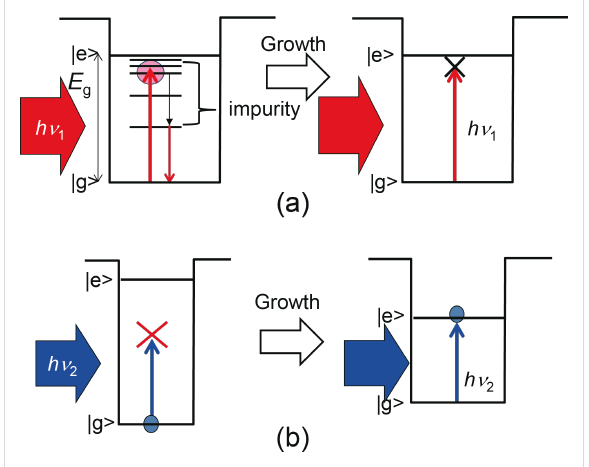
Figure 1: Schematic of the photo-induced synthesis. (a) Selective etching of defect levels. The relationship between the energy of an incident photon and the band structure of a ZAIS nanocrystal is shown in the left panel. As growth proceeds, the defect levels disappear, resulting in the high-quality nanocrystal at the end (right panel). (b) Controlling the size of a nanocrystal. The relationship between the energy of an incident photon and the band structure of a ZAIS nanocrystal is shown in the left panel. As growth proceeds, the size of the nanocrystal increases and the band gap energy decreases below the energy of the incident photon. Electron–hole pairs are then excited and trigger an oxidation–reduction reaction in the ZAIS nanocrystal and growth halts (right